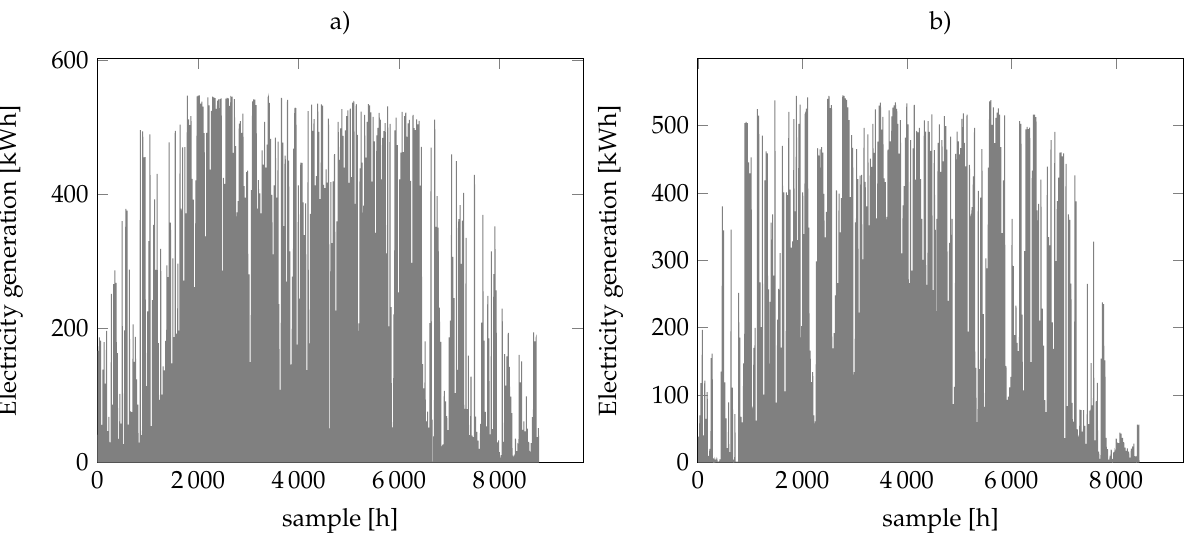
Figure 2. Power output for the analyzed PV farm for 2020 ( a ) and 2021 ( b